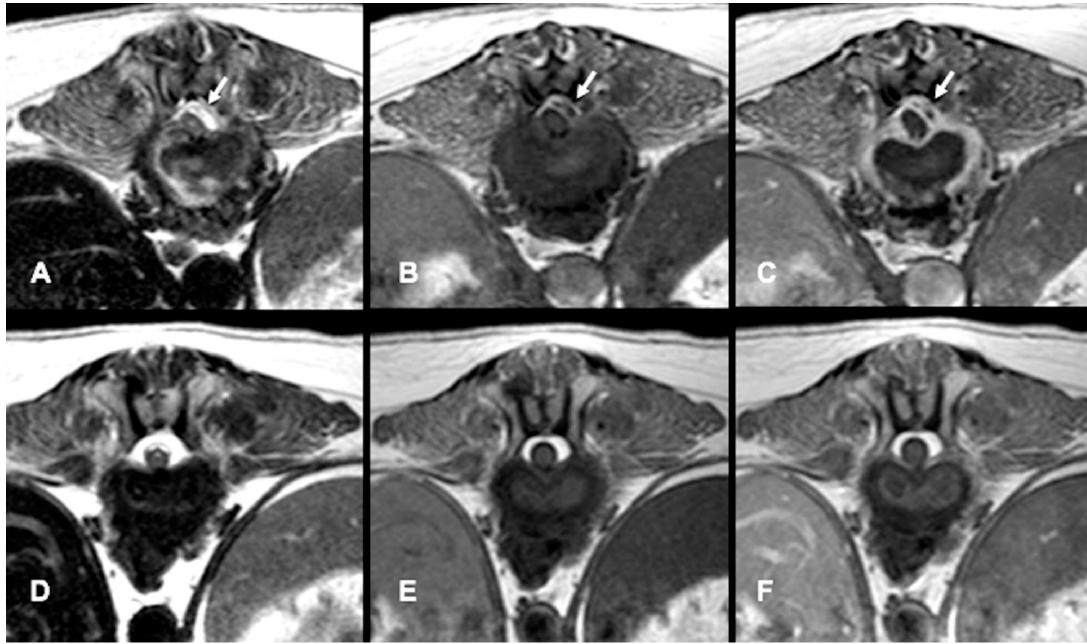
Figure 1. MRI transverse planes at the level of T13-L1 intervertebral disc at time of presentation ( A – C ) and follow-up at 4 months ( D – F ) in a dog diagnosed with SEE conservatively treated. A left dorso-lateral epidural lesion hyperintense on T2-W (arrow, A ) and hypointense on T1-W (arrow, B ) is displacing the spinal cord. On the T1-postcontrast image there is a ring enhancement of the epidural lesion (arrow C ) and irregular soft tissue enhancement around the intervertebral disc, which shows irregular shape, and heterogeneous hyperintense signal on the T2-W image ( A ). On the follow-up images on T2-W ( D ), T1-W ( E ) and T1-W postcontrast ( F ) there are no signs of the previous epidural lesion nor the contrast enhancement.